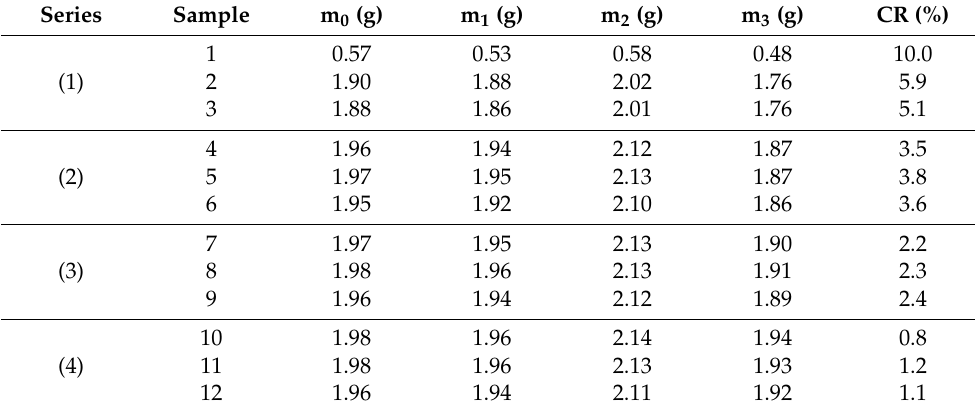
Table 5. Masses of composite samples: initial—m 0 , after drying—m 1 , after release—m 2 , and subse- quent drying—m 3